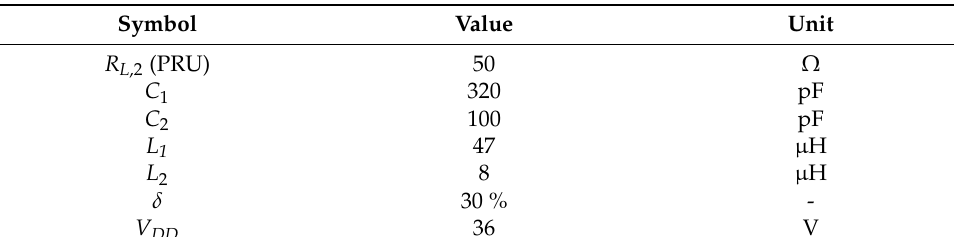
Table 4. Nominal parameters for ZVS control.